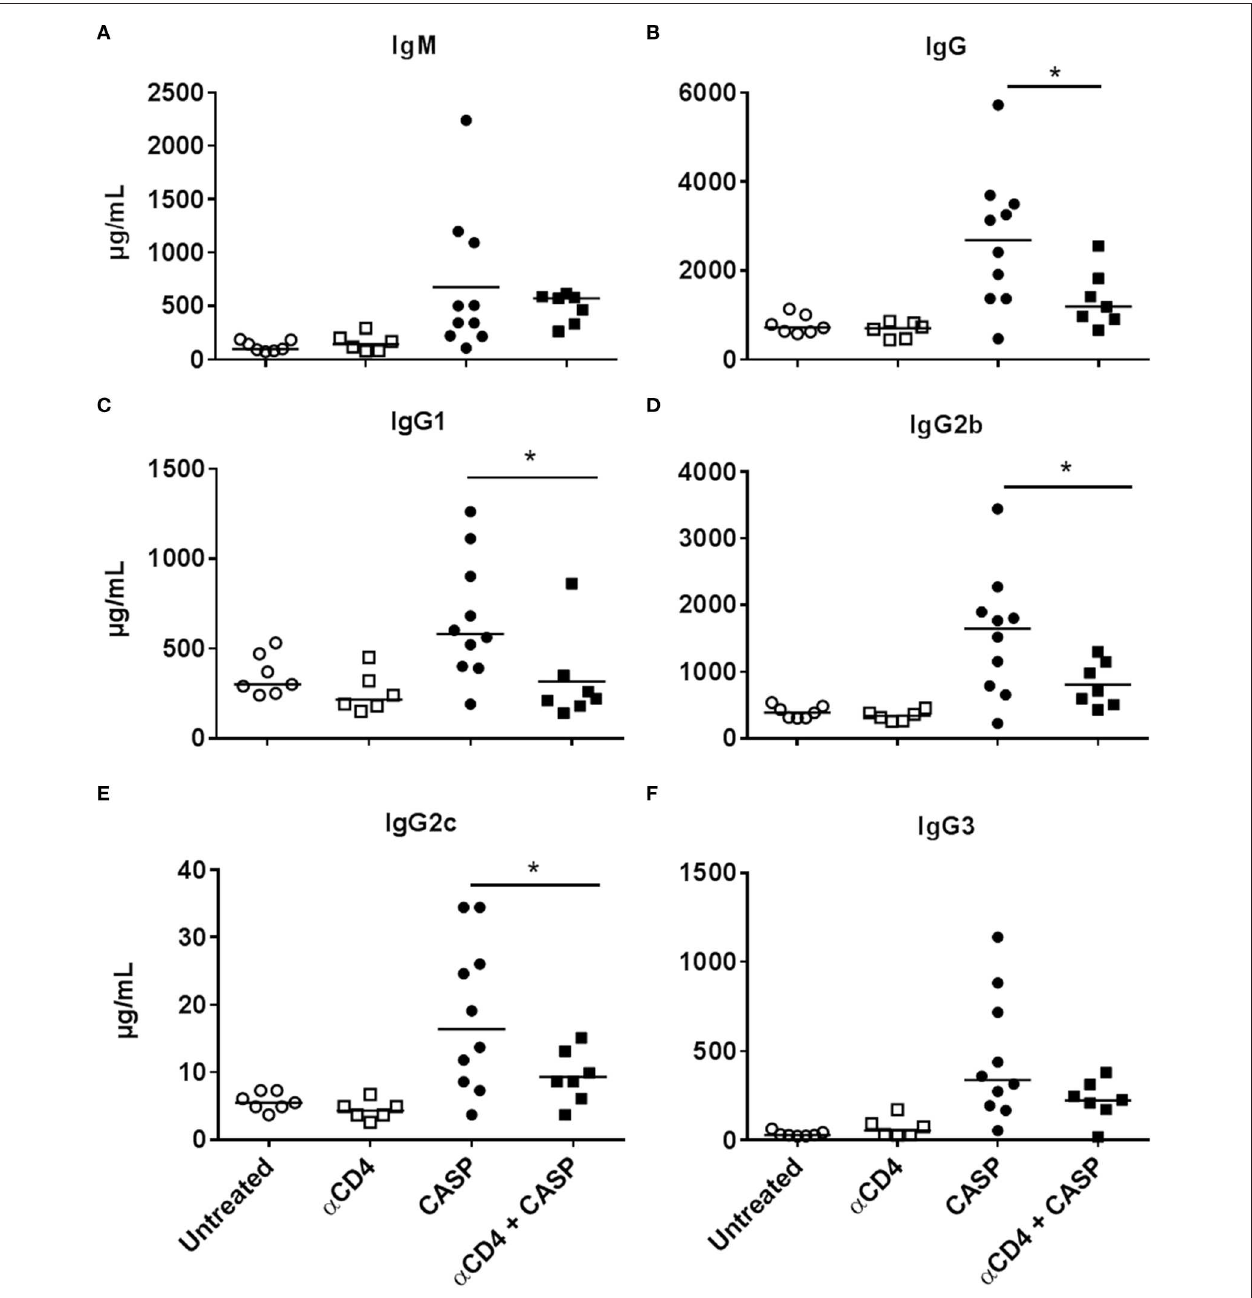
FIGURE 4 | Serum Ig concentration 14 days after CASP and CD4 + cell depletion. Female C57BL/6 mice received 150 µ g of a depleting anti-CD4 antibody ( α CD4; Gk1.5) i.p. three and one day before sepsis induction via CASP. Control animals remained untreated or received the depleting antibody only. Fourteen days after CASP, animals were anesthetized and blood was collected. IgM (A) and IgG (B) serum concentrations, as well as IgG subclass concentrations (C–F) , were measured by Luminex®-technology. Shown is the mean of the collective data from two independent experiments with a similar tendency. We used the One Way ANOVA and Bonferroni post-hoc test for selected pairs for statistical evaluation * p < 0.05. N = 6–10 per